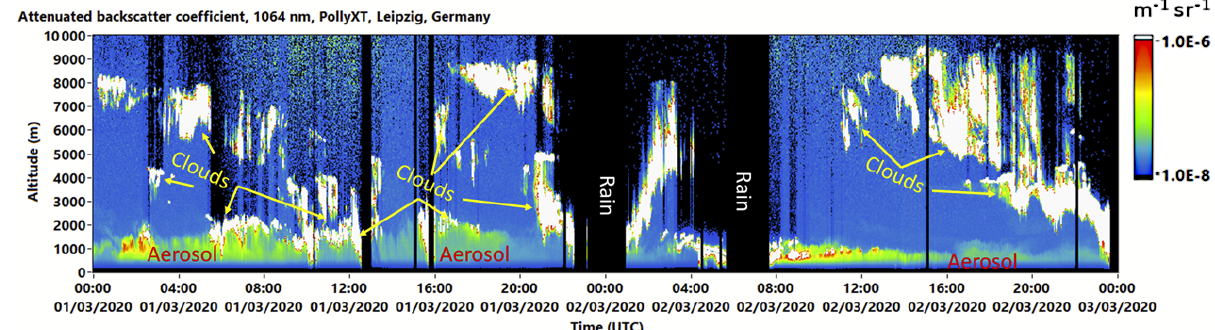
Figure 9. Detection of clouds, aerosol layers and periods with precipitation based on the vertical profiles of attenuated backscatter from the Polly-XT lidar at the TROPOS site.